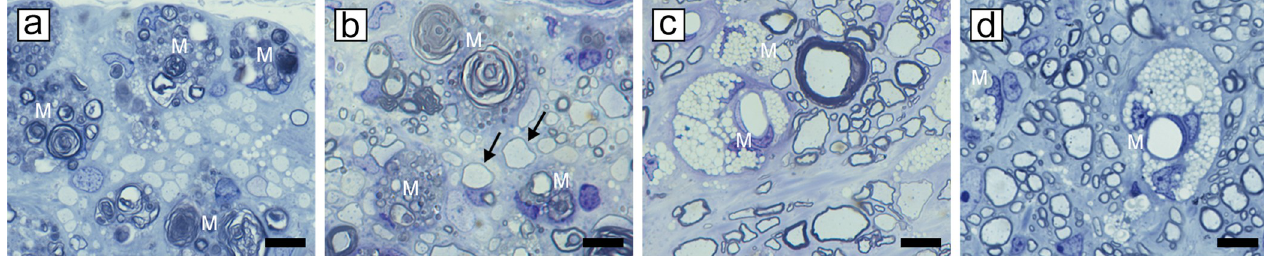
Fig 5. Macrophage content reveals the stage of disease. At the onset of myelin breakdown in the dorsal column of the spinal cord, myelin debris-filled macrophages are seen in an area of almost complete demyelination (a) though in other areas such macrophages lie adjacent to both demyelinated and remyelinated axons (arrows) (b) . When remyelination is complete and myelin debris has been digested, only lipid droplet-containing macrophages are seen in the neuropil and surrounding blood vessels in the spinal cord (c) and brain–body of the corpus callosum (d) . M = macrophages. Scale bar: 20 μ m.